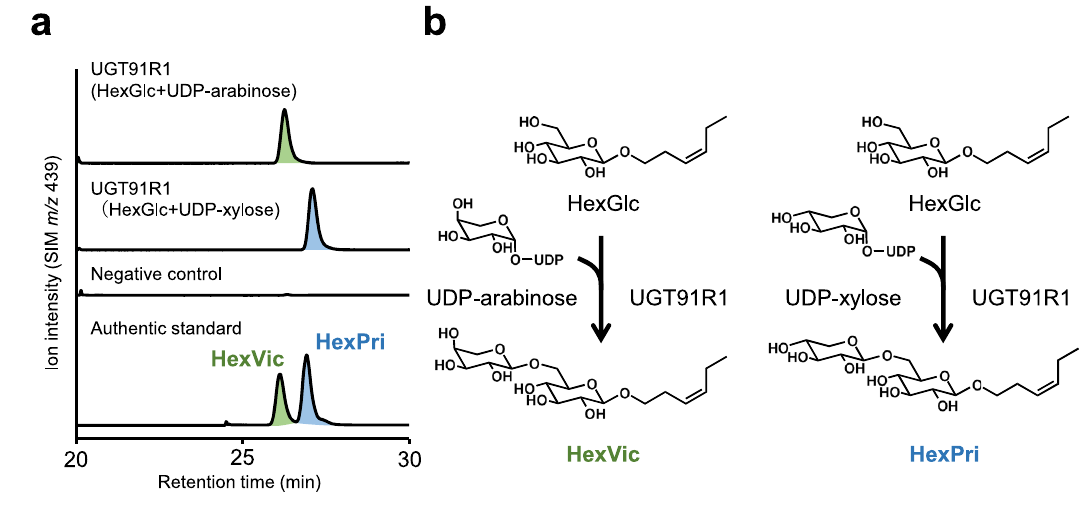
Fig. 3 | Biochemical characterization of tomato UGT91R1. a UGT91R1 catalyzes arabinosylation and xylosylation of HexGlc to produce HexVic and HexPri,